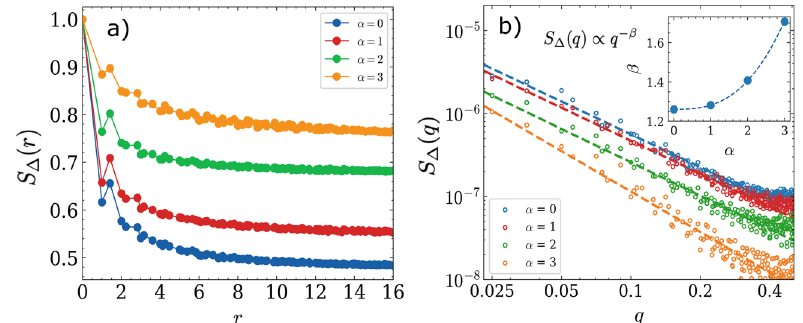
Fig. 4 Correlation function of the order parameter. a Spatial correlations of the order parameter S Δ ( r ), de fi ned in Eq. (4), calculated for several values of α at V ¼ 1 : 0. b The Fourier transform S Δ ( q ) of the correlation function S Δ ( r ), plotted in the log-log scale. The slope of its linear fi t at small q (dashed lines) yields the power exponent β in the limiting expression S Δ ( q ) ∝ q − β . The inset shows the power exponent β as a function of α . The lines connecting numerically obtained points serve as guides for